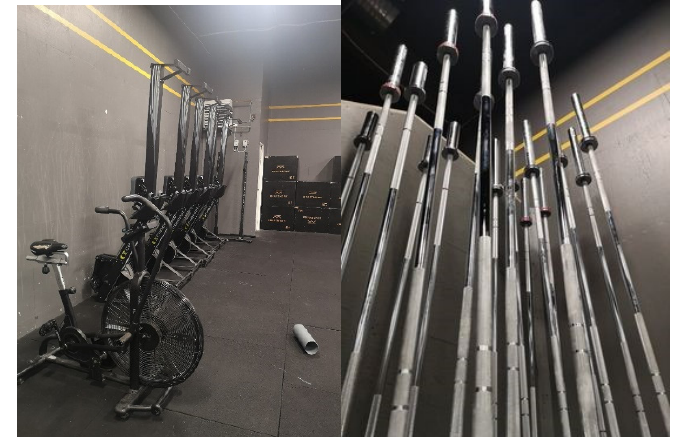
Figure 4. Boxen Umeå Syd (A CrossFit box in Umeå Sweden.